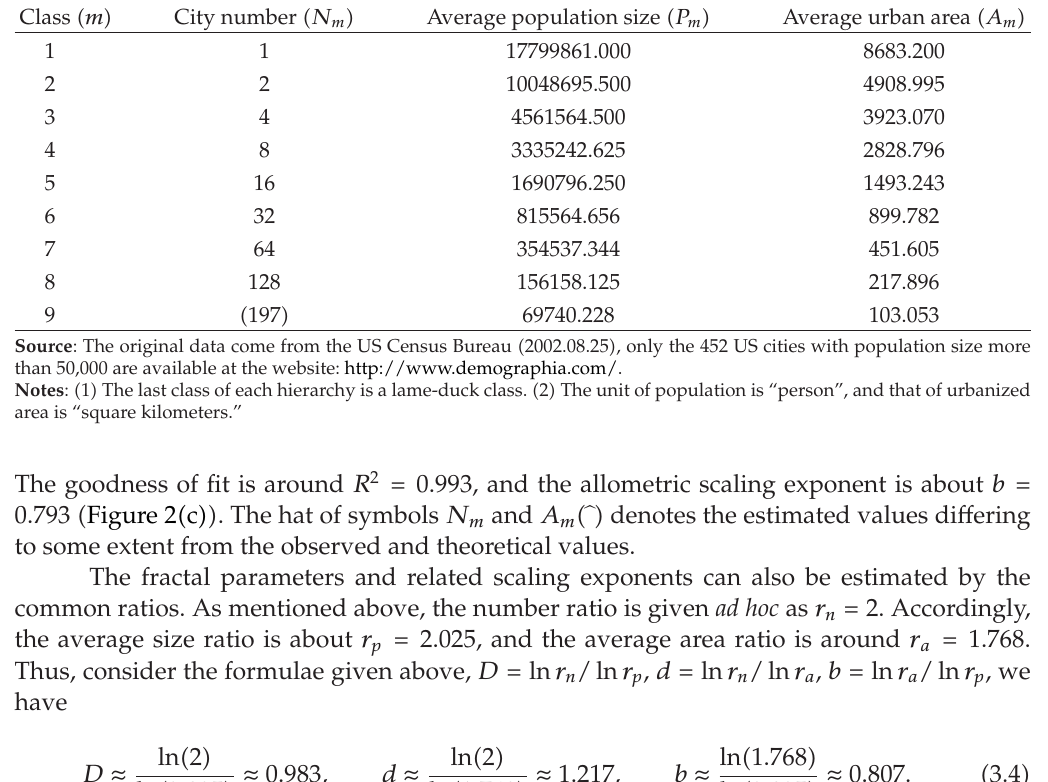
Table 3: The hierarchy of the 452 cities in USA and the related measures (cid:6) 2000 (cid:7) . Class (cid:6) m